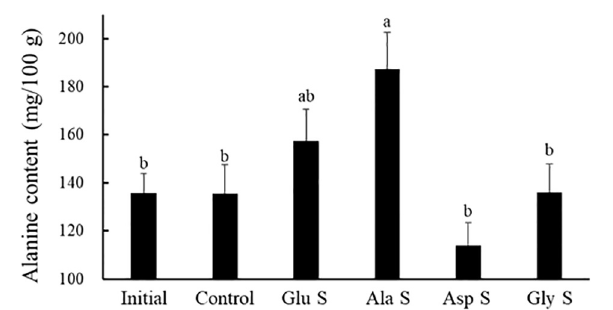
FIGURE 1 | Alanine content (mg/100 g in wet weight) in Mesocentrotus nudus gonads of the initial group and each treatment group at the end of the experiment (mean ± SE) ( n = 16). An explanation of Initial, Control, Glu S, Ala S, Asp S, and Gly S is provided in Table 2 . Lower-case letters indicate significant differences among groups ( p < 0.05 by Tukey’s